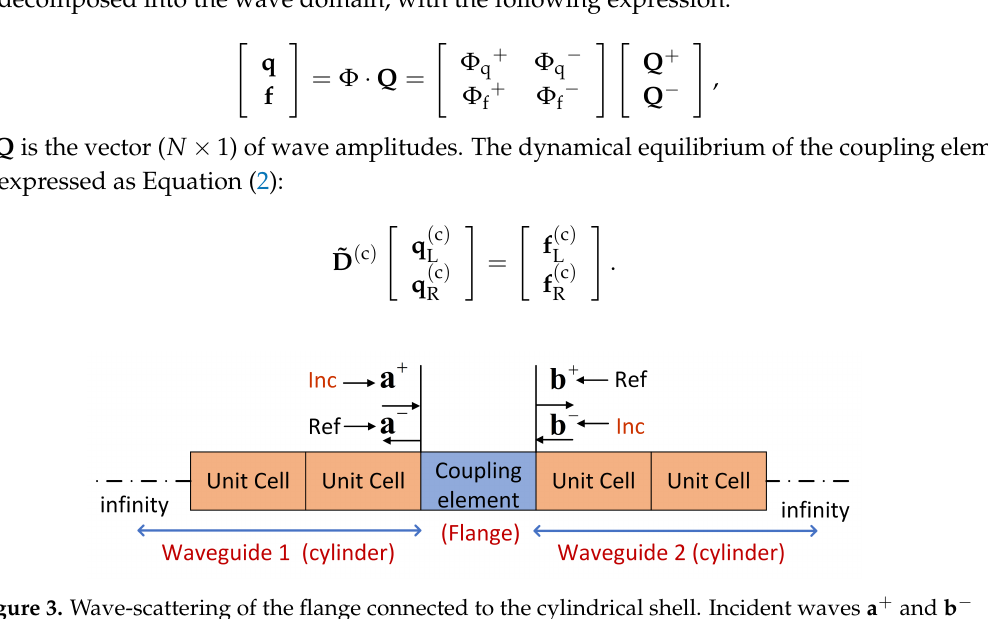
Figure 3. Wave-scattering of the flange connected to the cylindrical shell. Incident waves a + and b − enter couple element and reflect respective waves a − and b +